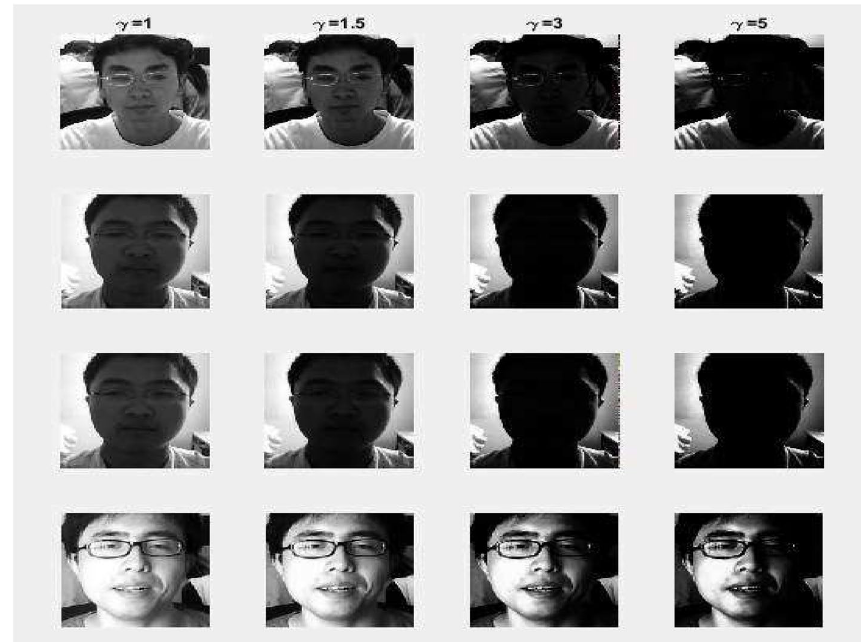
Fig. 7 Impact of the Gamma power law on the degradation of the contrast profile of the original image (in the corresponding synthetic versions). Results are shown for γ 1 (no transformation) and for 1.5, 3, =